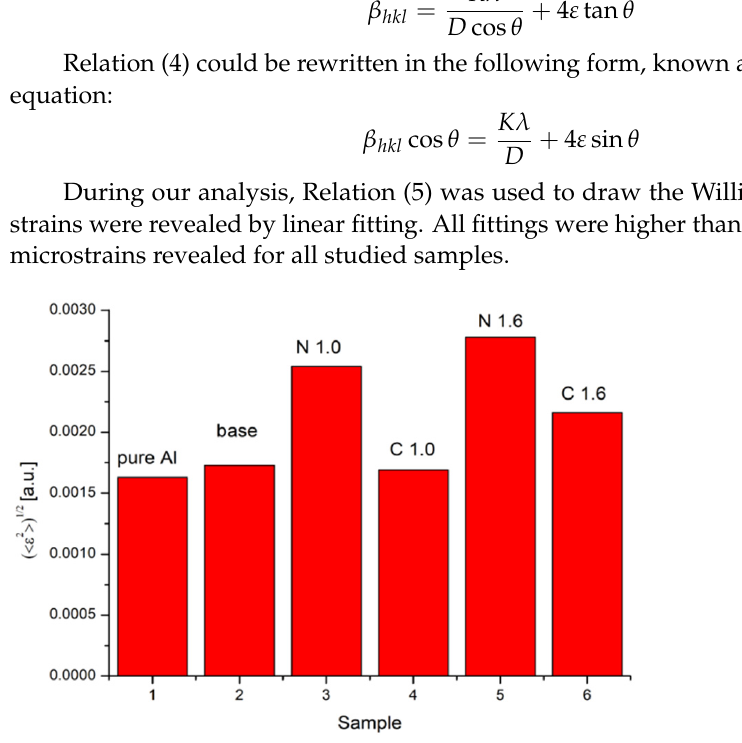
Figure 6. Microstrains calculated for all studied samples.